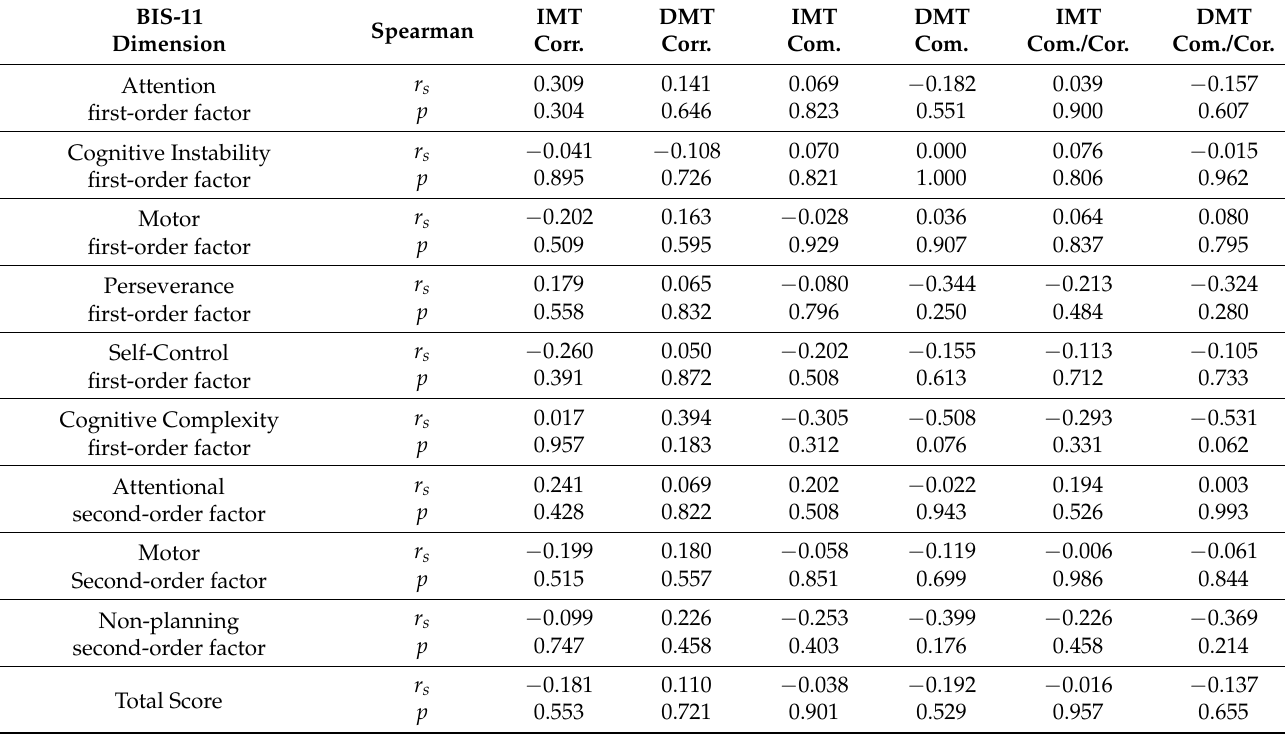
Table A3. Testing for Spearman correlations between dimensions of the BIS-11 questionnaire and IMT/DMT in patients with OCD ( n = 13). Abbreviations: Com., commission errors; Corr., correct responses; DMT, delayed memory task; IMT, immediate memory task; p , significance (2-sided); r s , Spearman correlation coefficient.